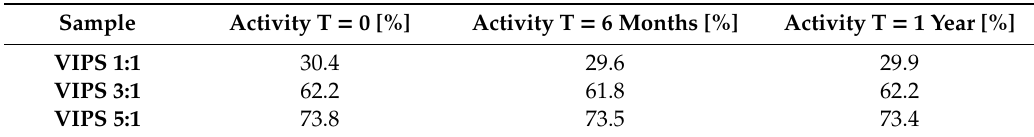
Table 3. Activity of dry VIPS capsules at di ff erent